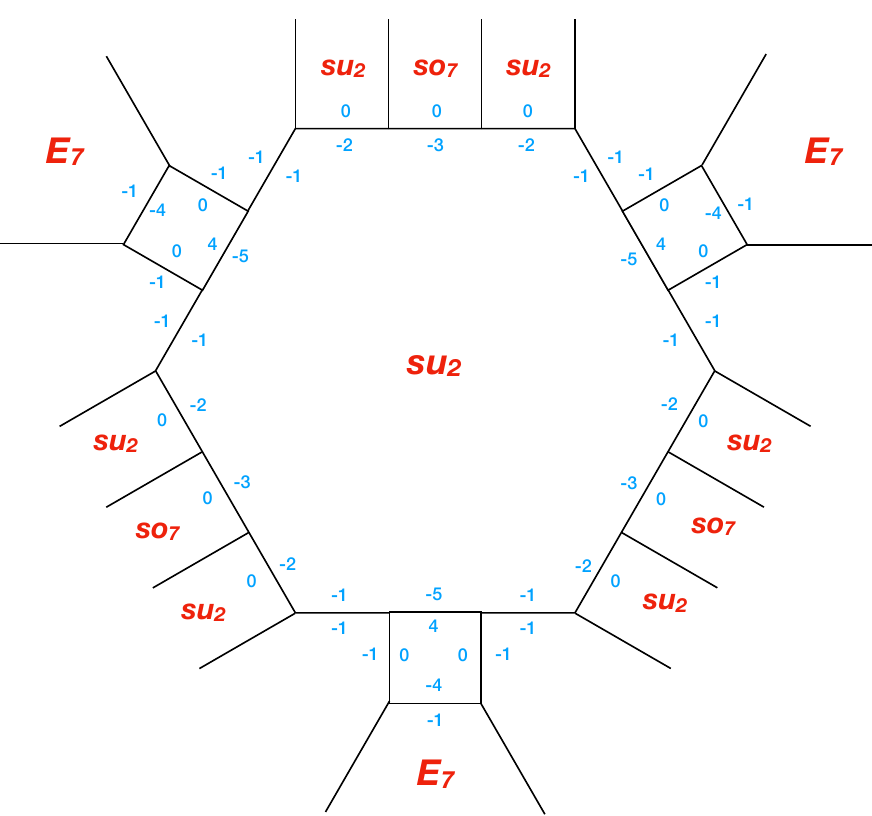
Figure 5 . The fully blown up E 7 { E 7 { E 7 Yukawa